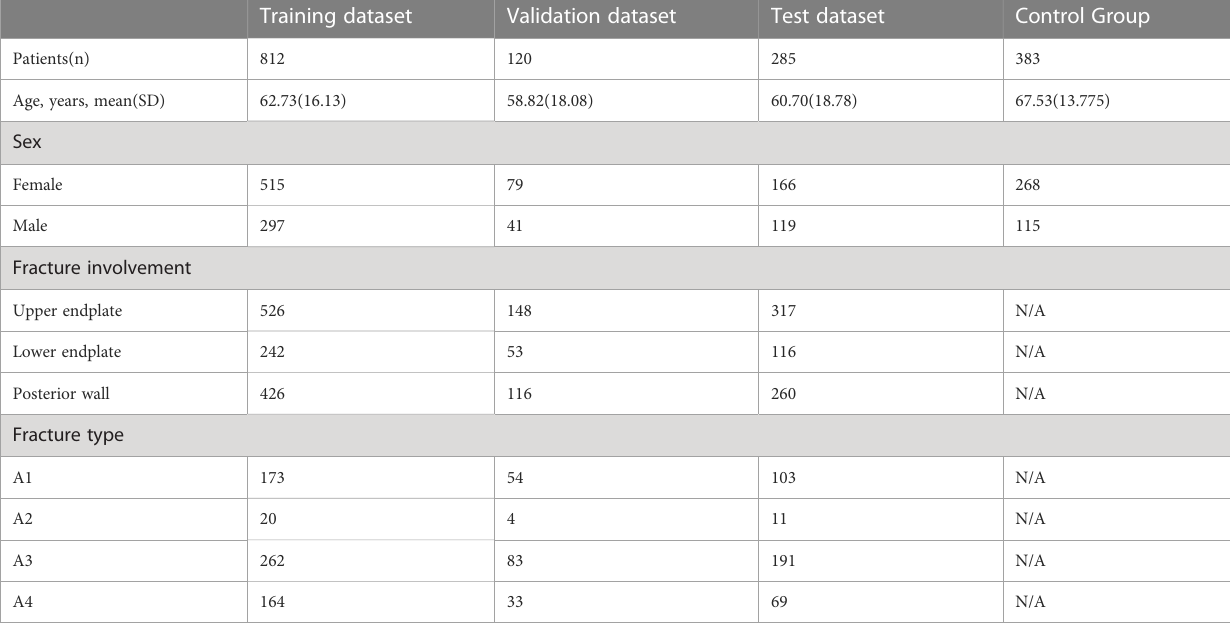
TABLE 1 Summary statistics of patients and control group.